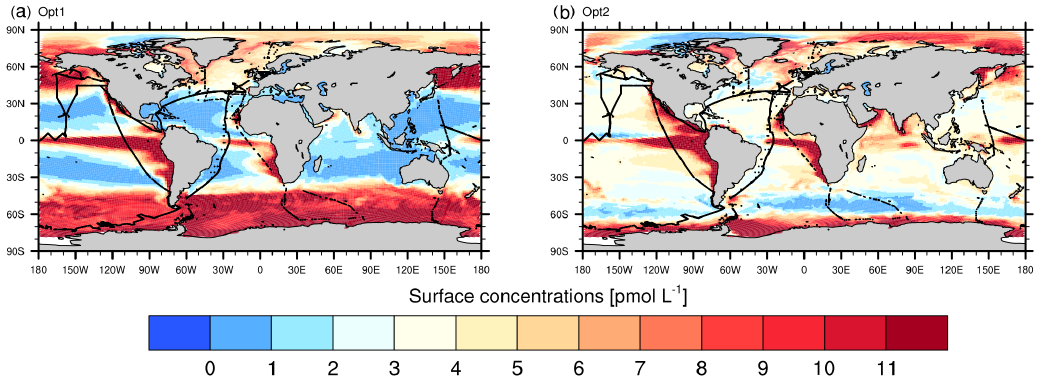
Figure 3. Annual mean methyl iodide concentration (pmolL − 1 ) in the experiment, with normal biological production, Opt1 (a) , and with production from stressed picocyanobacteria, Opt2 (b) . Black dots mark the sampling locations of CH 3 I observations (shown in Fig. 1). Table 3. Global fraction of observations best presented by the respective model experiment (as shown in Fig. 10 for individual locations and seasons), considering only single source experiments, only mixed source experiments, and all experiments (upper part). Global root mean square deviation (RMSD; pmolL − 1 ), root median square deviation (RMSD (median); pmolL − 1 ), and global median of the ratio observation (lower part). Source Biological Photochemical Mixed ID Opt1 Opt2 Opt3 Opt4 Opt134 Opt24 Percentage of simulated data closest to observations Including only single source exp. 13.12%